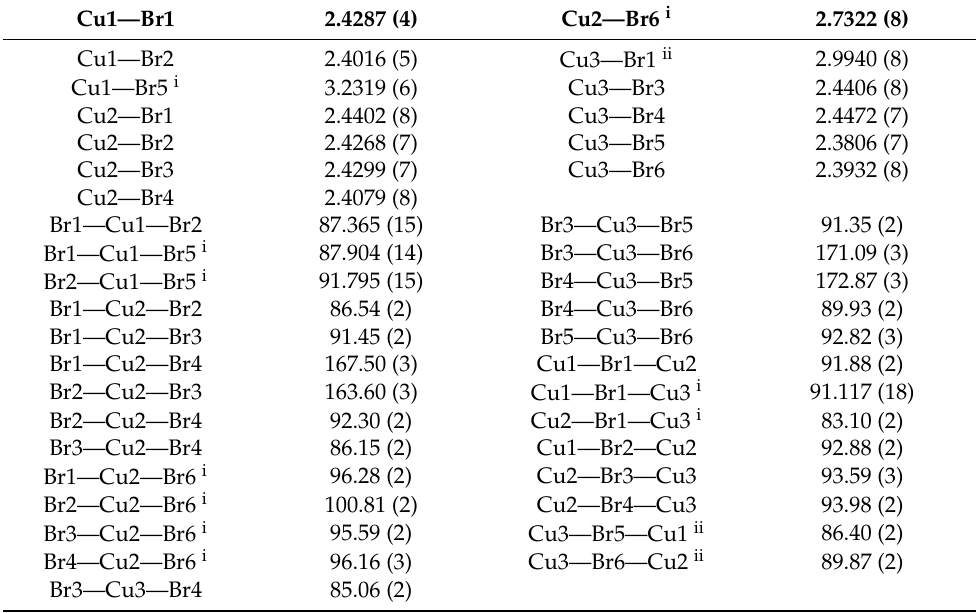
Table 2. Selected geometric parameters (Å, ◦